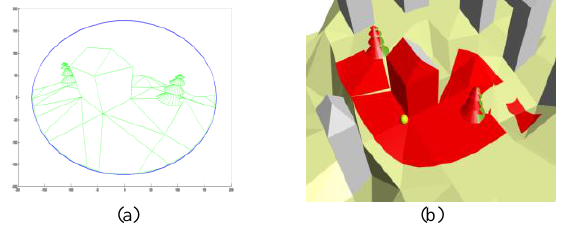
Figure 15. (a) The perspective view of geosensor; (b) The area covered by the geosensor in CityGML model